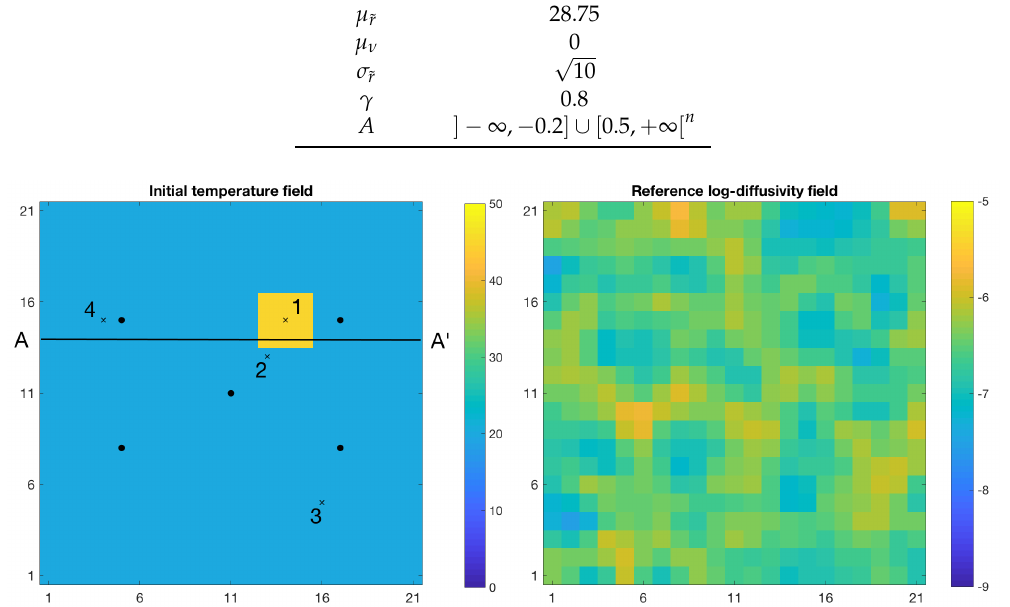
Figure 12. Initial temperature ( ◦ C) field ( left ) with data collection points · and monitoring locations × and reference log-diffusivity field ( right ).